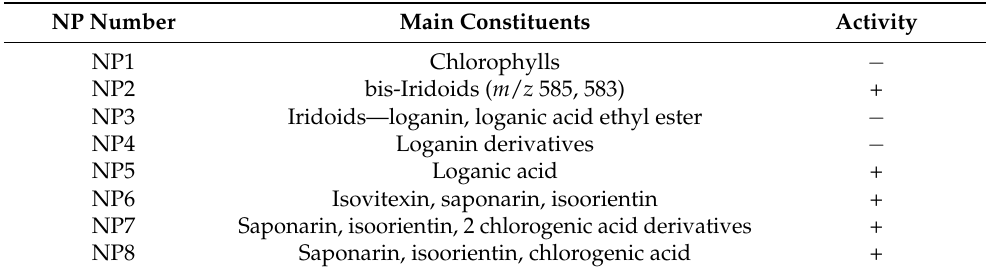
Table 2. Preliminary screening for activity against stationary phase B. burgdorferi